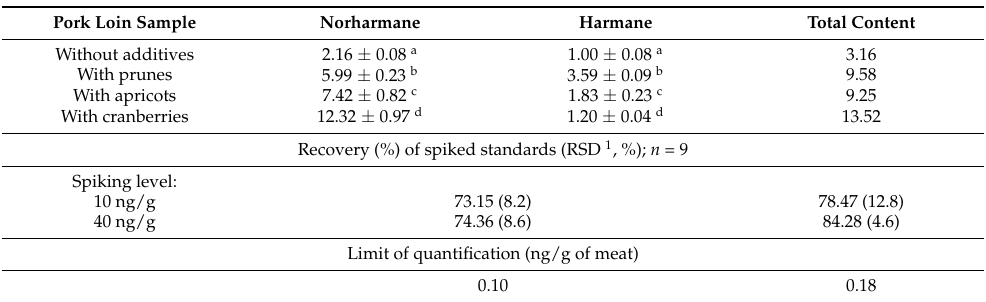
Table 2. Concentrations (recovery corrected values) of β -carbolines in meat cooked with and without additives (ng/g). The results are presented as means ± standard deviations (SD), corresponding to duplicate HPLC analyses of fractions obtained by triplicate extractions ( n = 6). Different letters in each column denote statistically significant differences ( p <